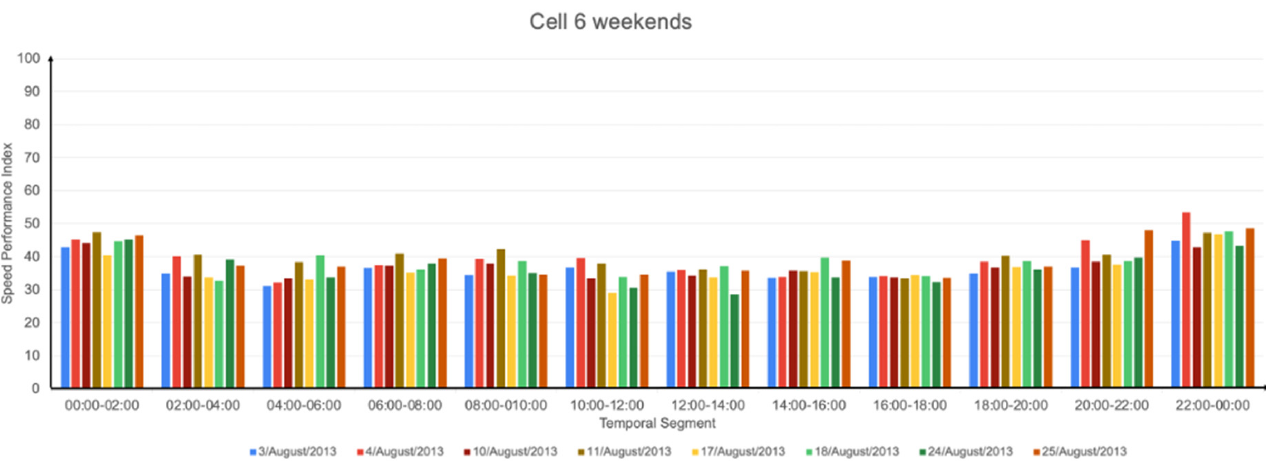
Figure 16. Calculated SPI for the weekends, cell 6 with Vmax = 100